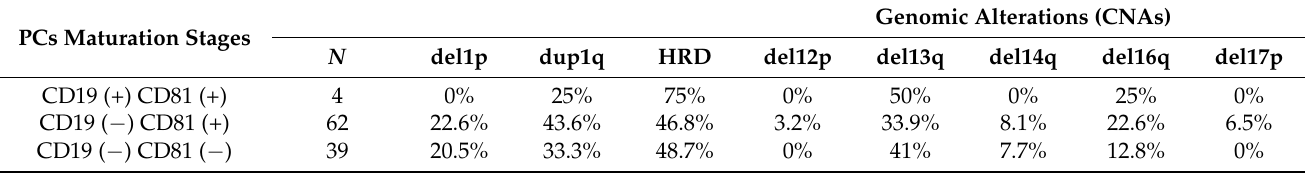
Table 4. Pairwise association between maturation stages of PCs and